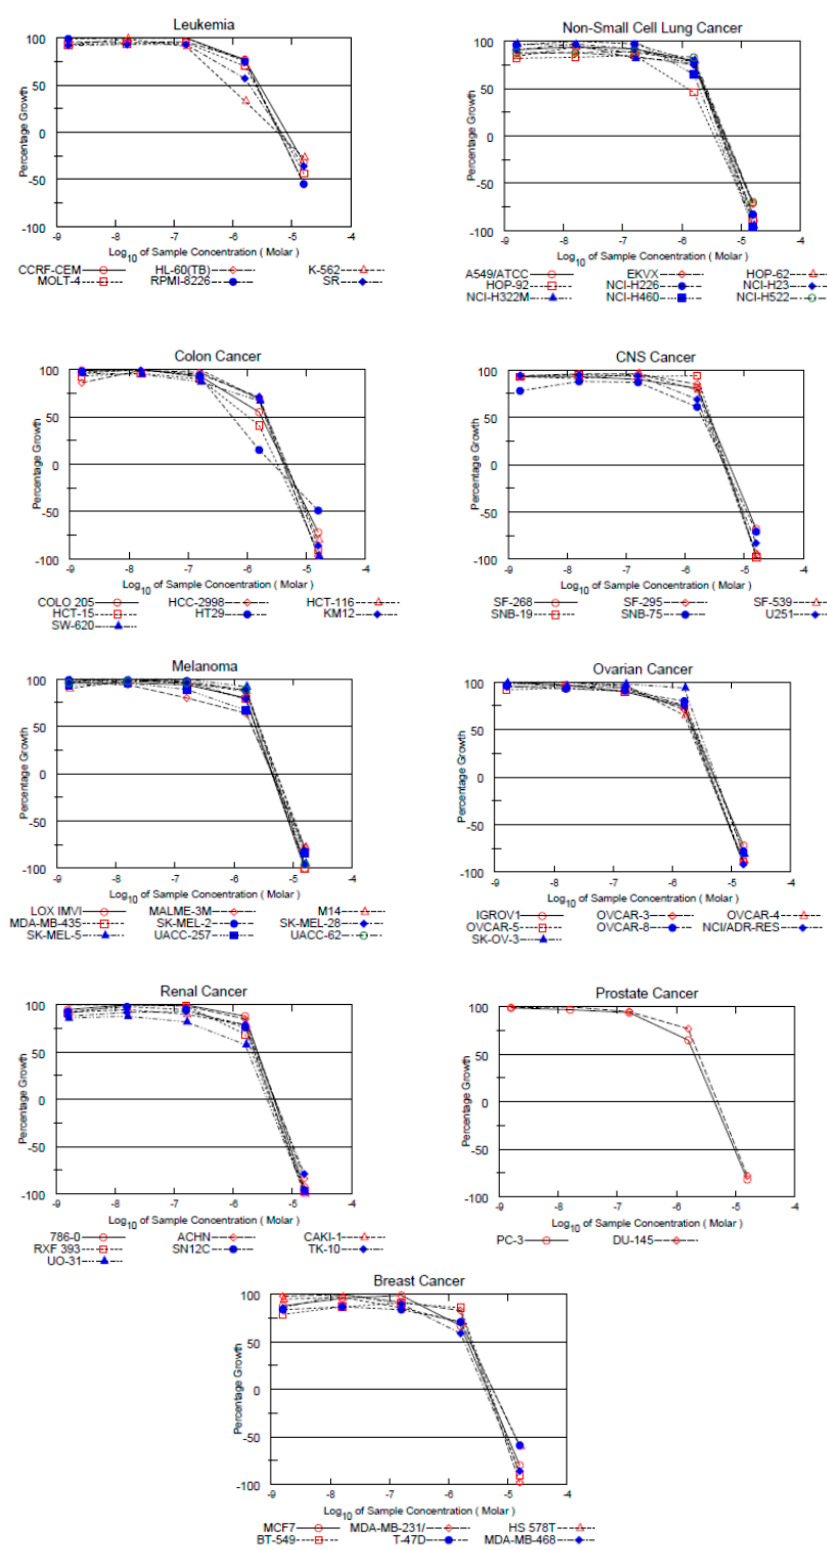
Figure 3. Dose-response curves of compound 28 on different subpanels. Data obtained from NCI in in vitro disease-oriented human tumor cell screen (for details, see the work of [39]) compounds were tested in triplicates.